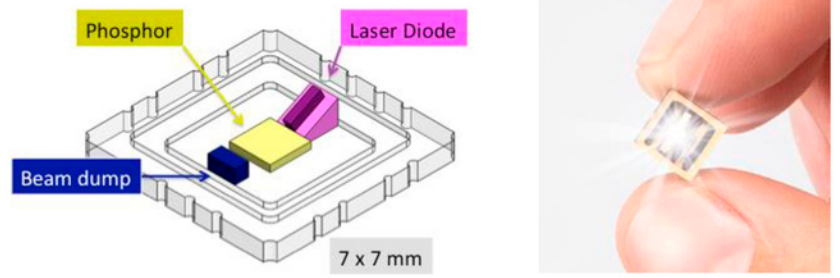
Figure 5. An integrated surface mount device (SMD) package for laser lighting applications. Figure reused from [73] with permission from SPIE.